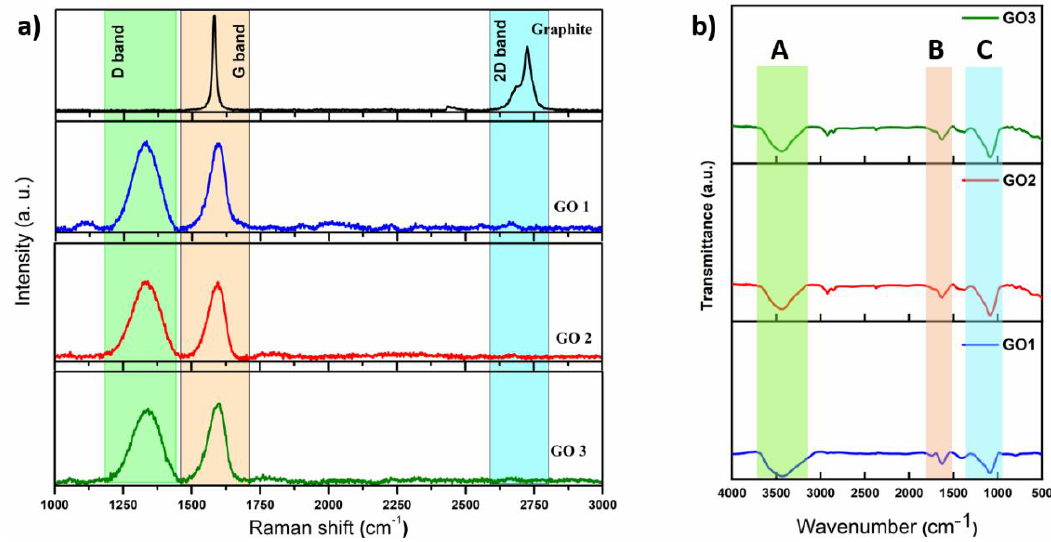
Figure 4. ( a ) Raman spectra of GOs synthesized; ( b ) FTIR spectra of GOs synthesized.